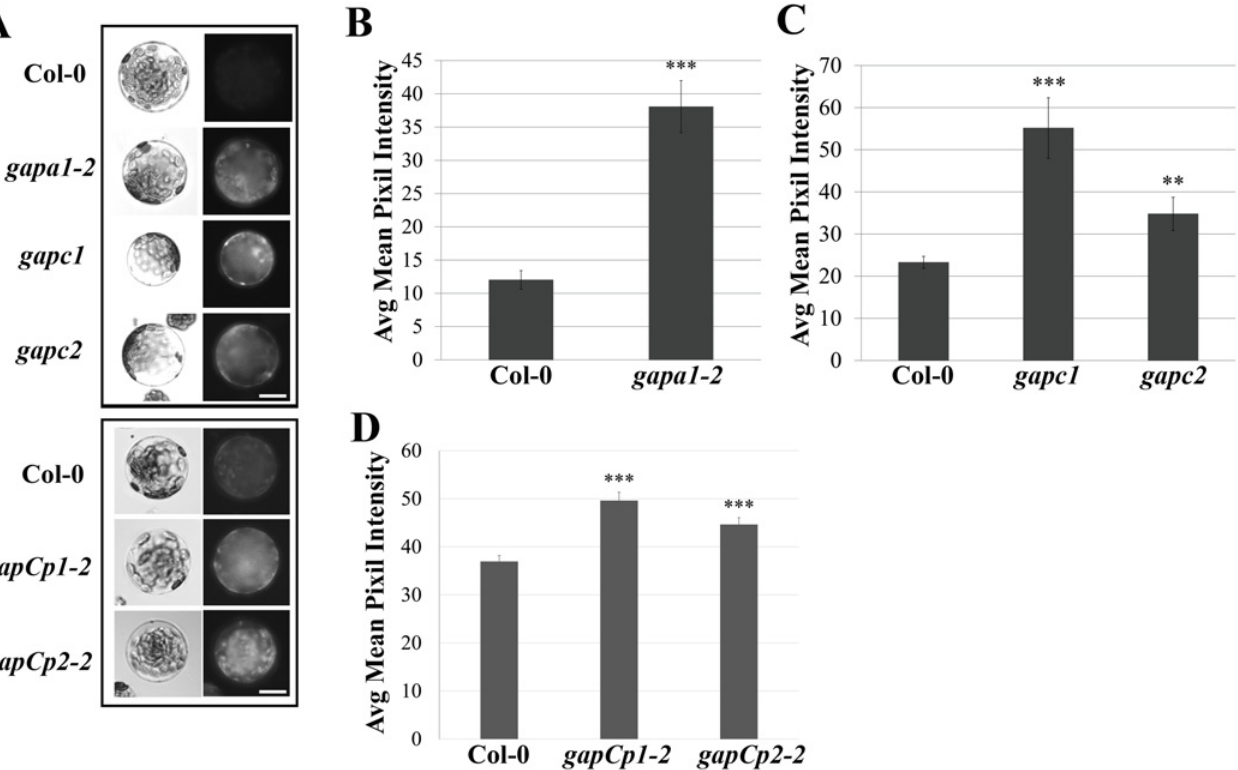
Fig 5. GAPDH knockout lines exhibit an increase in basal intracellular ROS. (A) Histochemical detection of ROS in protoplasts isolated from the indicated genotypes upon incubation with the fluorescent probe H 2 -DCFDA. Protoplasts were left under bright light for 1h and 750 nM of H 2 -DCFDA was added 15 min prior to imaging. Protoplasts were imaged using an epifluorescence microscope fitted with a GFP filter. Boxes indicate separate experiments and bar = 10 μ m. (B-D) Quantification of H 2 -DCFDA fluorescence. Pixel intensity corresponding to fluorescence of intact protoplasts was quantified across three experimental replicates (n (cid:1) 25) and combined for statistical analyses. Statistical differences were detected by a two-tailed Student ’ s t test ( α = 0.01 ** and = 0.001 *** ).